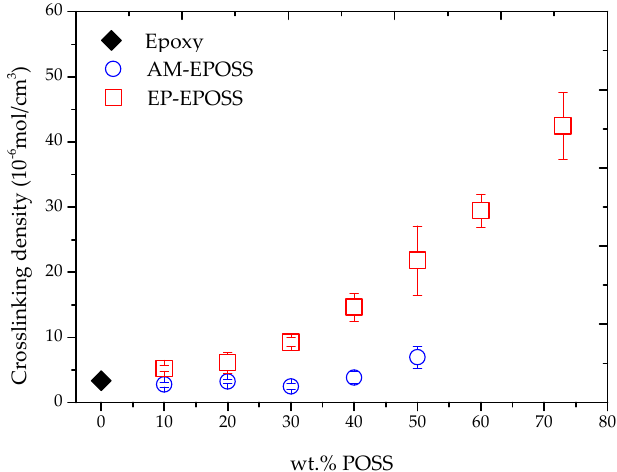
Figure 6. The e ff ect of POSS type and content on the crosslinking density of EP–EPOSS and Figure 6. The effect of POSS type and content on the crosslinking density of EP–EPOSS and AM– AM–EPOSS EPOSS samples.